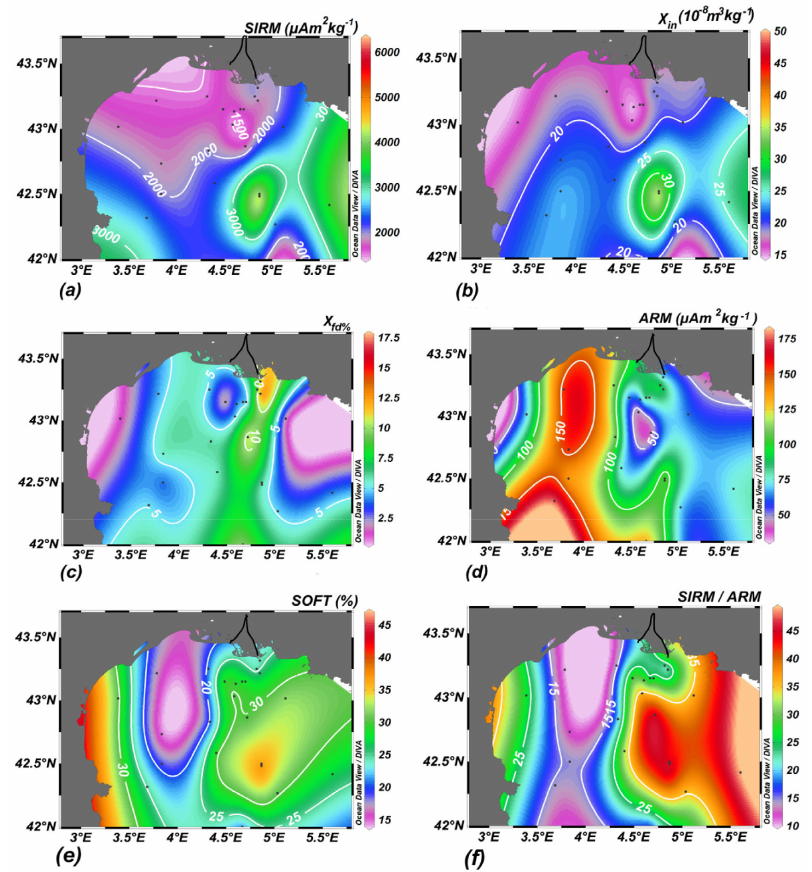
(10 − 8 m 3 ·kg − 1 ); ( c ) χ ; ( d ) in fd%